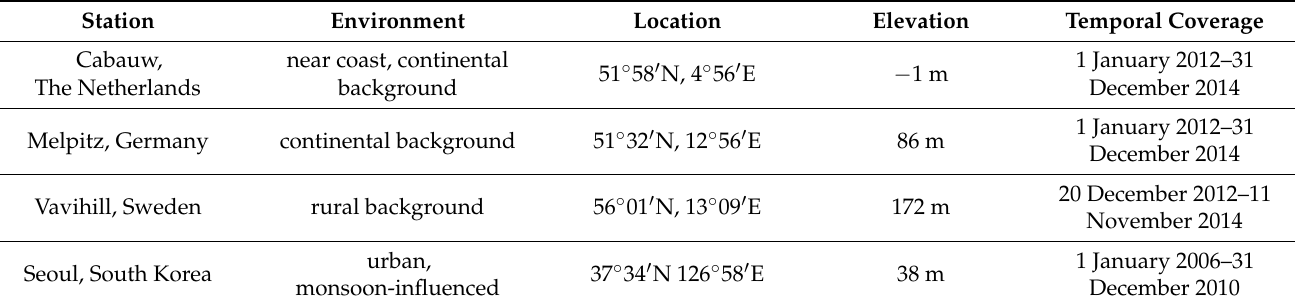
Figure 1. Location of the in situ sites used in this study. The large inset gives a closer look of Europe. The small insets present daytime (blue) and nighttime (black) ground tracks of CALIOP that fall within a 3° × 3° latitude – longitude grid box centered at Melpitz and Barrow, respectively, for a randomly selected month. The world map in the background is taken from http://www.shadedrelief.com/natural3/pages/textures.html (accessed on 7 July 2022). Table 1. Details of the in situ stations considered in this study.